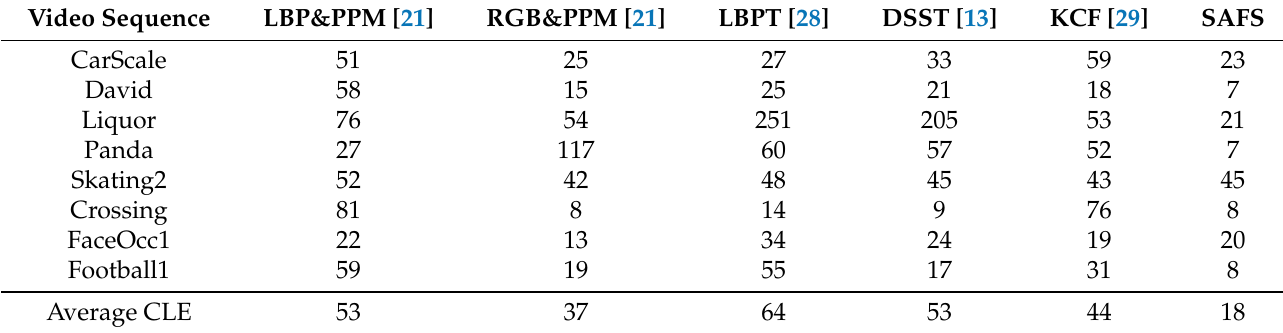
Table 3. The CLE (pixels) of the SAFS method compared with other five